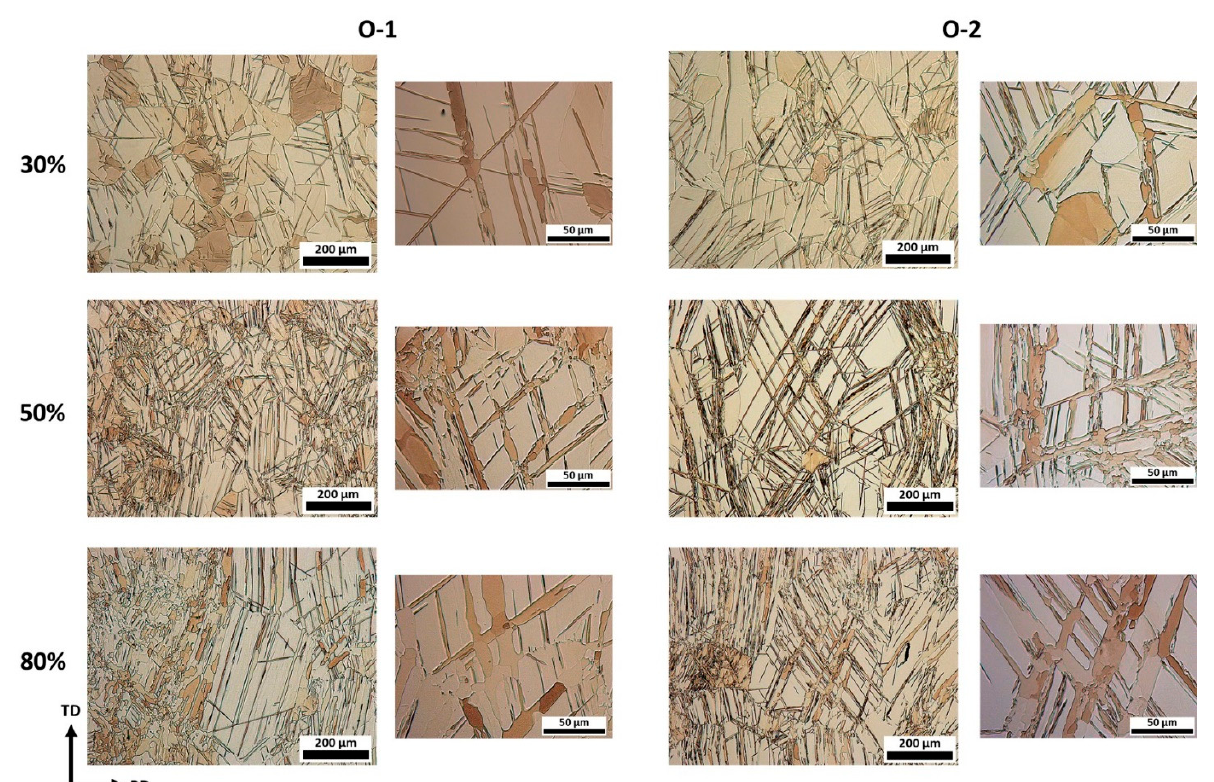
Figure 3. Optical micrographs at 200 × and 500 × magnifications of the rolling direction (RD)-transversal direction (TD) plane after magnesium single crystal rolling at different strains of both studied orientations.